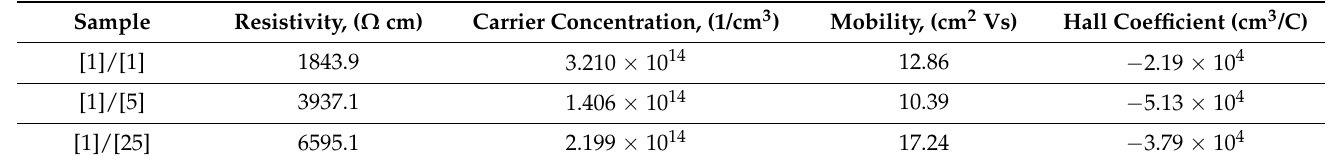
Table 5. Electrical properties for various CdS thin film molar